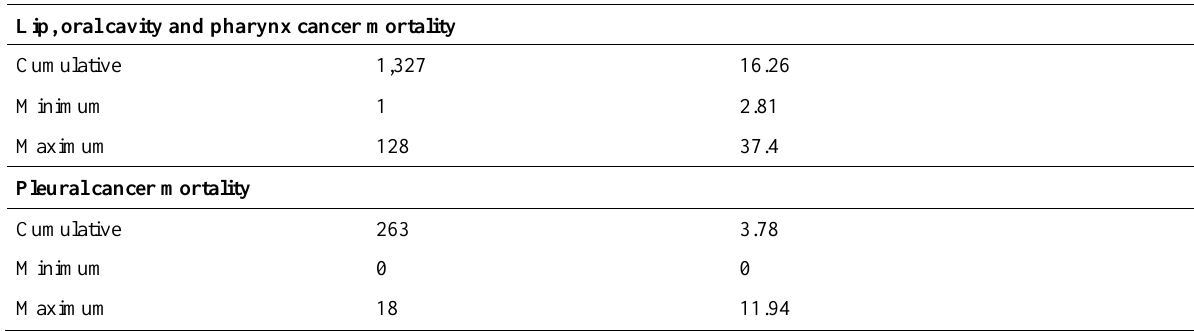
Table 1. Cumulative, maximum and minimum number of mortality and age-adjusted rates per 100,000 person-years by county,